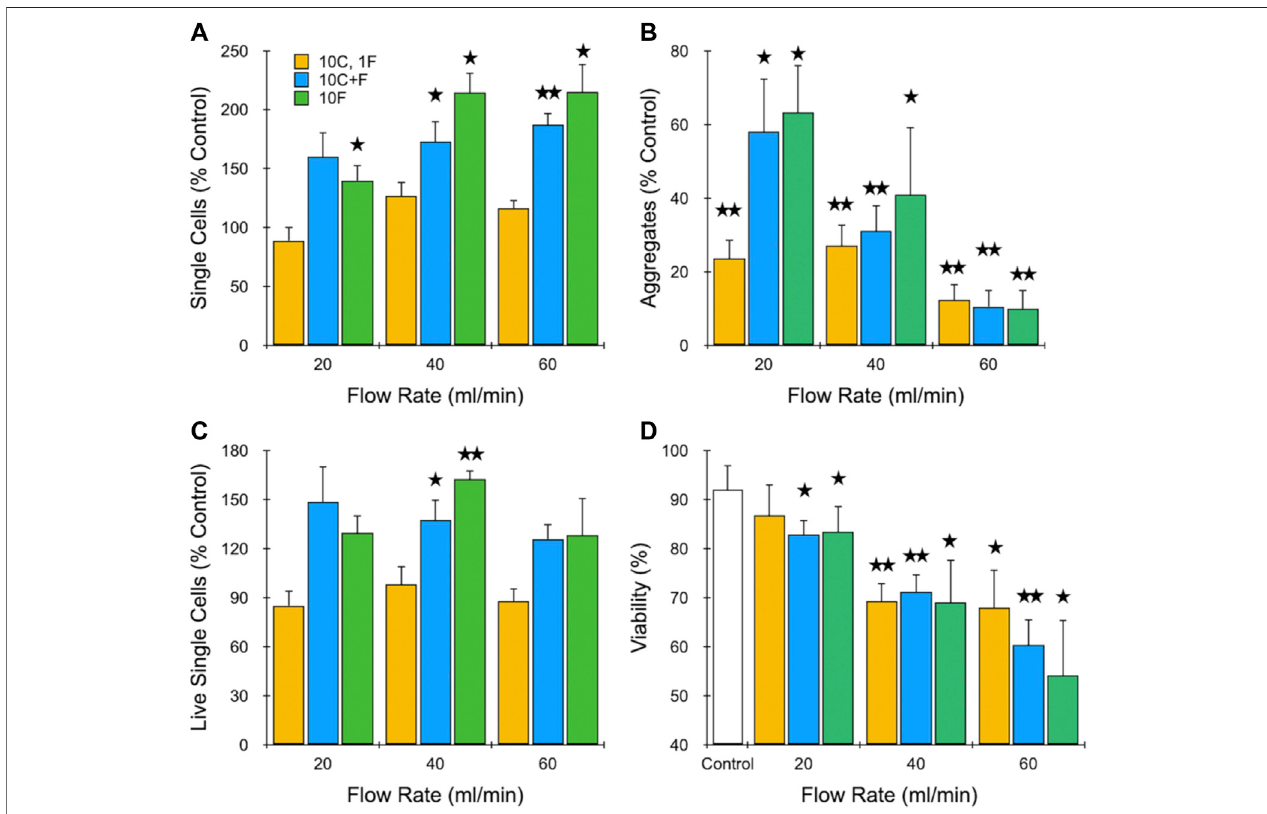
FIGURE 3 | Evaluation of different dissociation formats using cell aggregates. MCF-7 cells were passed through the channel module 10 times and fi lter module once(10C,1F),both channeland fi ltermodules10times(10C+F),orthe fi ltermodule10times (10F)atdifferent fl owrates.Resultsareshownfor (A) totalsinglecell, (B) aggregate, and (C) live single cell yeilds, which are all normalized to the unprocessed control. Also presented is (D) single cell viability. Optimal results were observed at 40 ml/min using multiple fi lter module passes. Data are presented as mean values ± SEM from at least three independent experiments. Two-sided t test was used for statistical testing. Stars indicate p < .05 and double stars indicate p < .01 relative to the unprocessed control.